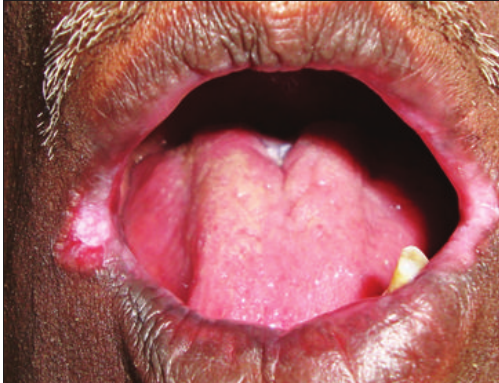
Figure 3: Angular cheilitis on the right and left